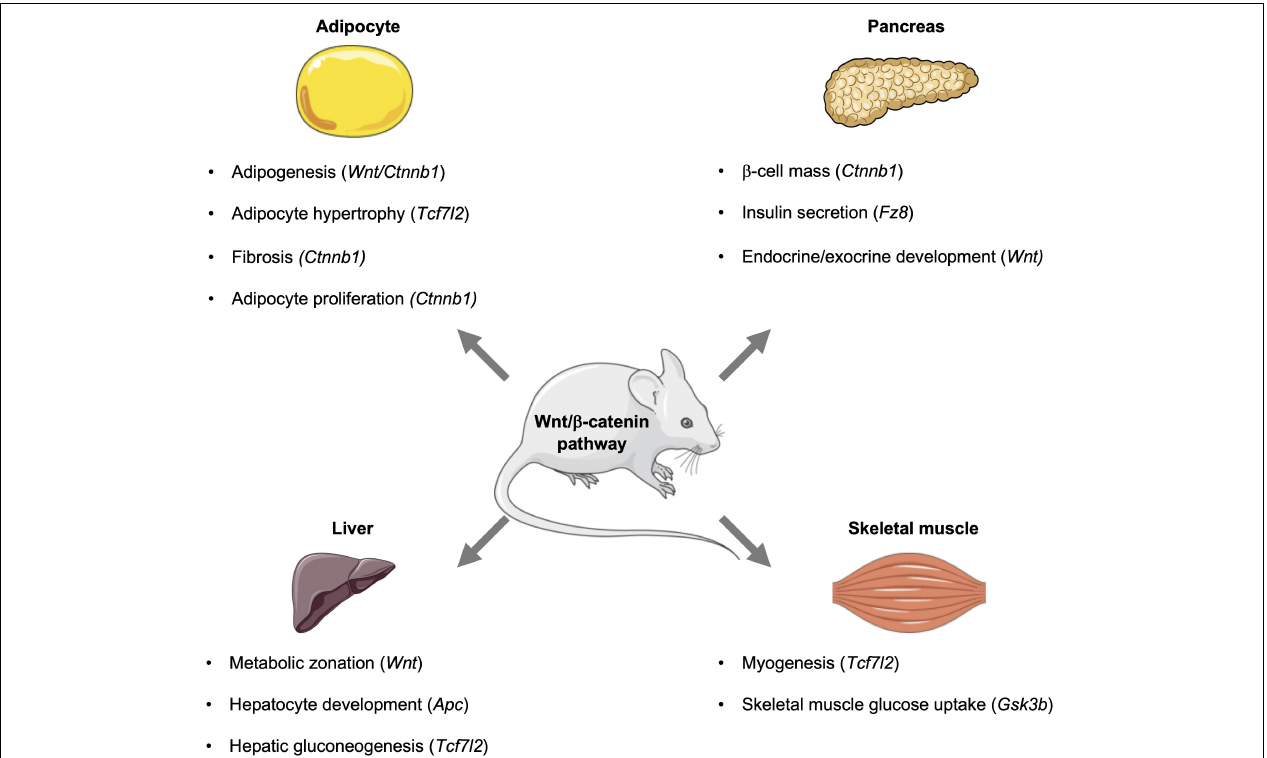
FIGURE 2 | Influence of the Wnt signaling pathway and its downstream effectors in metabolic tissues. In mice, the Wnt signaling pathway influences metabolic events in key tissues, including the pancreas, adipose, liver, and skeletal muscle. Activation of this pathway can influence the development of tissues and organs, as well as signaling events that control glucose homeostasis and metabolism. This figure was made with modified images from Servier Medical Art (Creative Commons Attribution 3.0 Unported